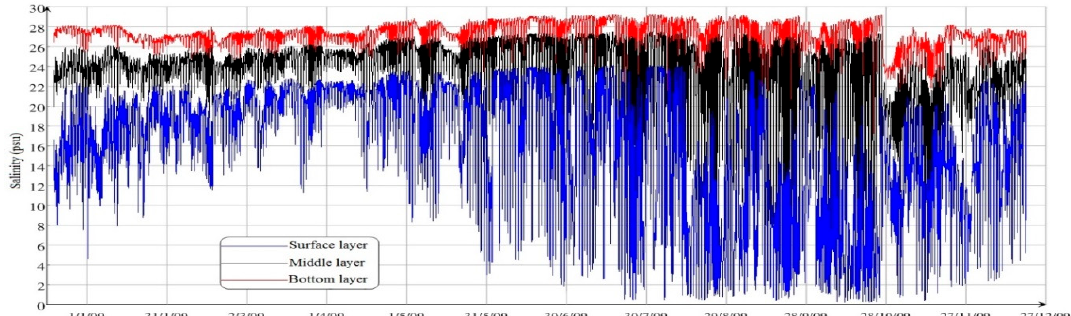
Figure 16. Time series of the distribution of salinity (psu) at station S12.